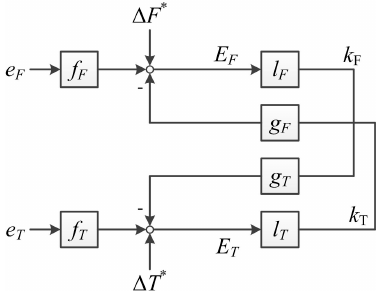
Figure 10. Structure of the proposed effect factors controller.